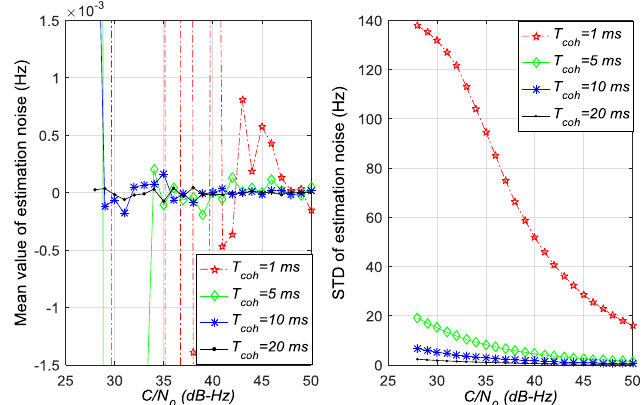
Figure 6. Mean values and standard deviations of estimation noise for ATAN2 discriminator in different C / N 0 and T coh .